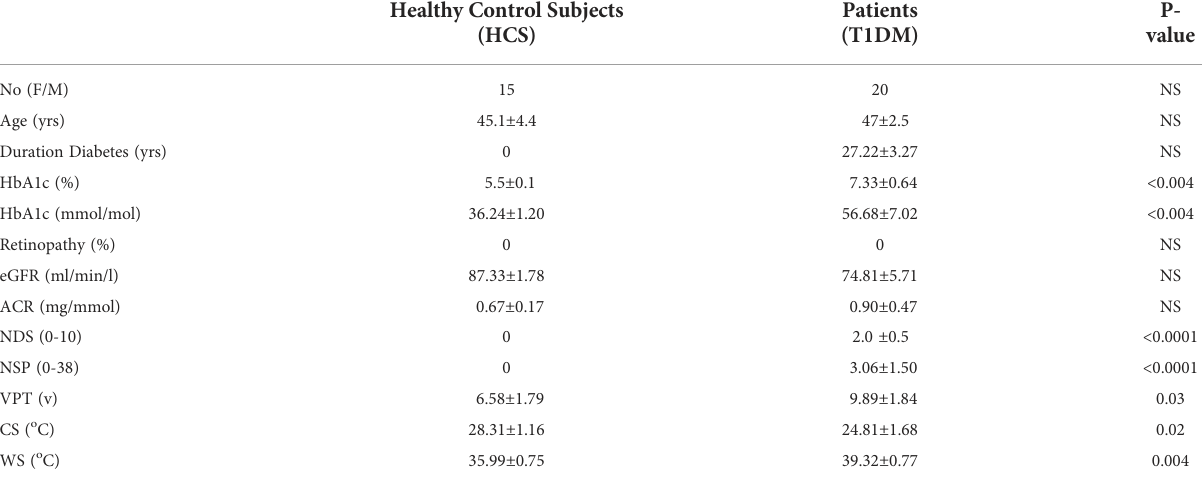
TABLE 1 Demographic data and neurological